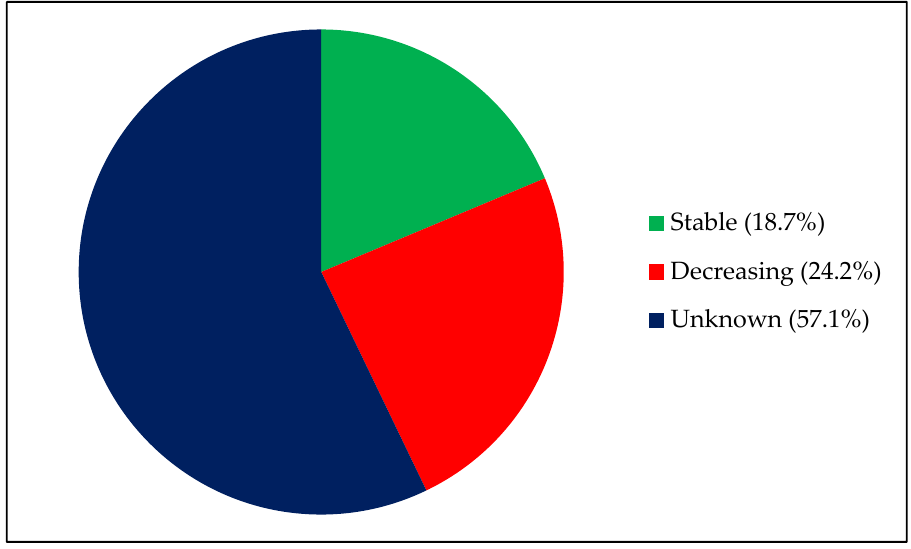
Figure 8. Global fish population trend.